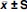
Effect of short-term SD on escape latency of rat after GCIR (x¯±S, n = 6).The rats in the GCIR group spent longer in their escape latencies to find the platform than the rats in the S group during the five training days. The rats in the GCIR+12hSD*3d group exhibited a significantly shorter escape latency compared with the GCIR group during the five training days. * P<0.05 compared with the S group; # P<0.05 compared with the GCIR group.